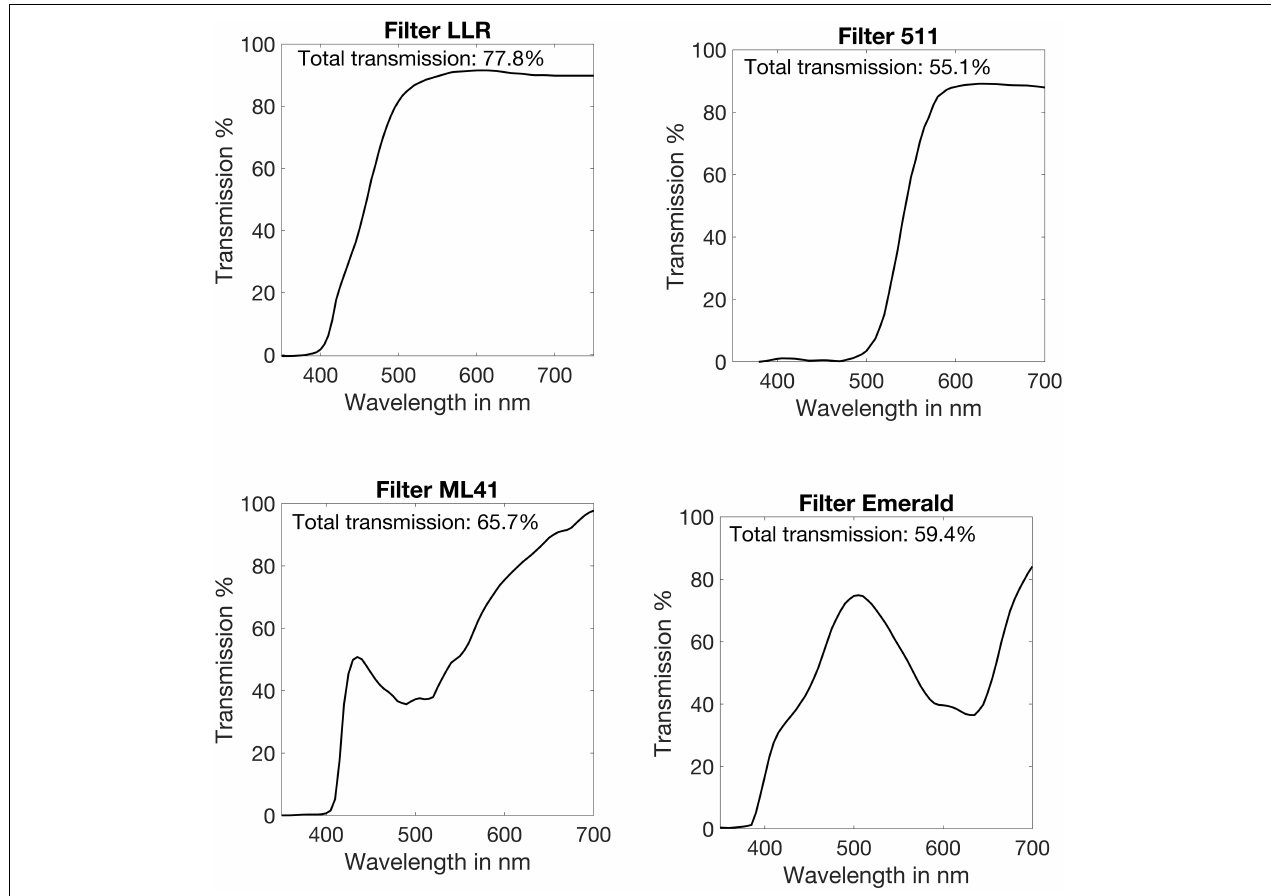
FIGURE 1 | Transmission curves of the filters used in this study. LLR: a long pass LED light reduction filter; 511: 511 nm long-pass filter; ML41: Pink filter; Emerald: Green filter.